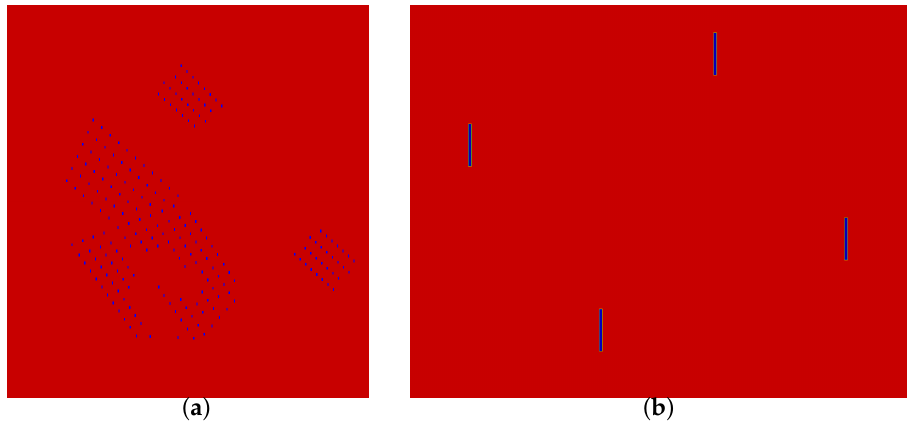
Figure 6. Interface function for a wind farm test case featuring 219 turbines: ( a ) overview, and ( b ) closeup to four turbines. The range of the interface function is [0,